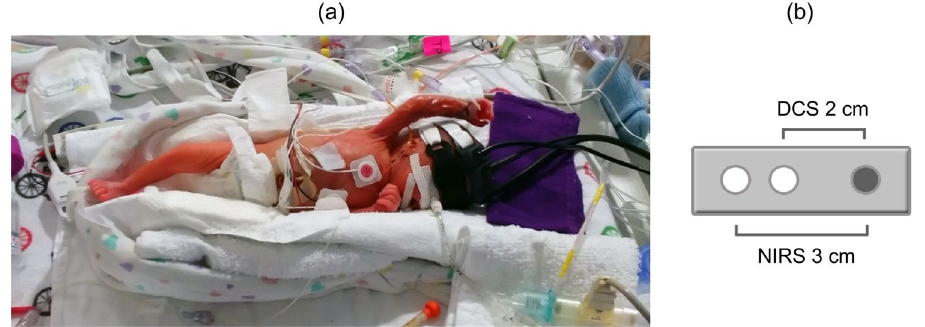
Figure 5. ( a ) Premature infant with optical probes secured to the forehead and a phototherapy eye shield, ( b ) schematic of probe holder showing the position of the NIRS (3-cm SDD) and DCS (2-cm SDD) sources and the common detection location (shaded circle). Probe holder was 5 × 2 × 1